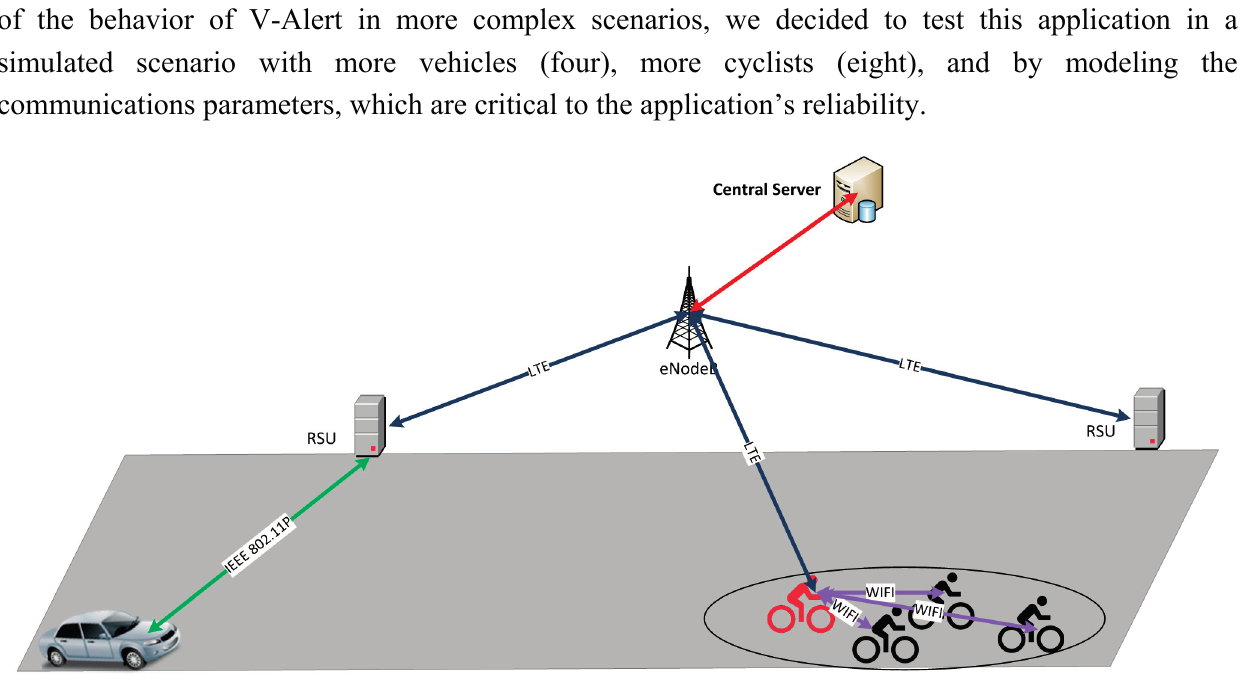
Figure 1. Description of the simulated